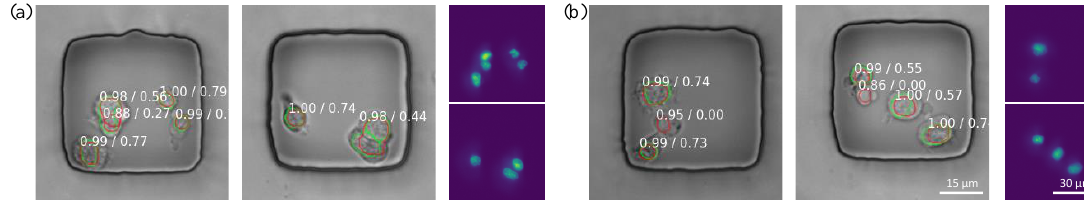
Figure 7. Representative examples of errors in detection. Green lines and red lines denote masks from blob detection and Mask RCNN, respectively. Blue images are nuclei channel from biological experience. ( a ) Mask RCNN wrongly merged two nuclei into one because of the mask label error; ( b ) Mask RCNN raised false positive prediction when the cell extends its